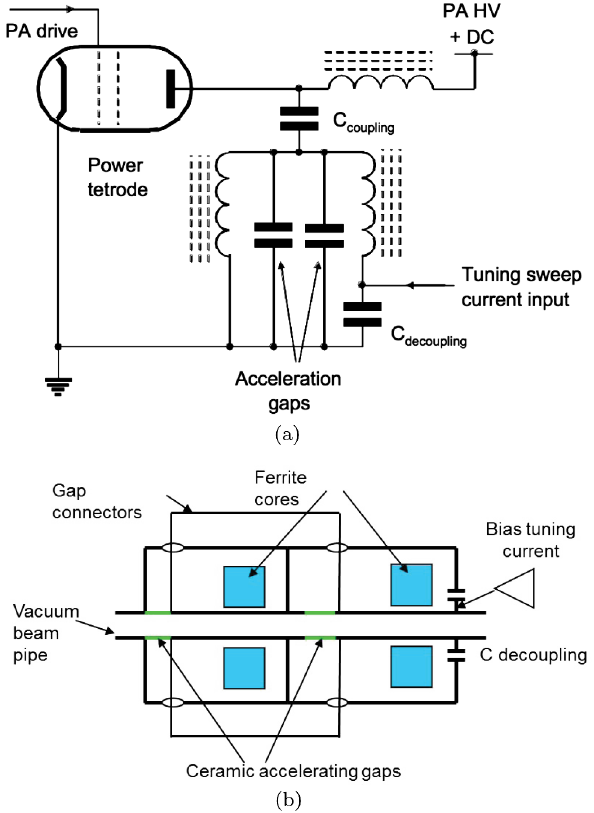
FIG. 22. (a) Equivalent circuit of dual-gap cavity and associ- ated tetrode power amplifier (PA), with core biasing current input and (b) schematic of cavity design.